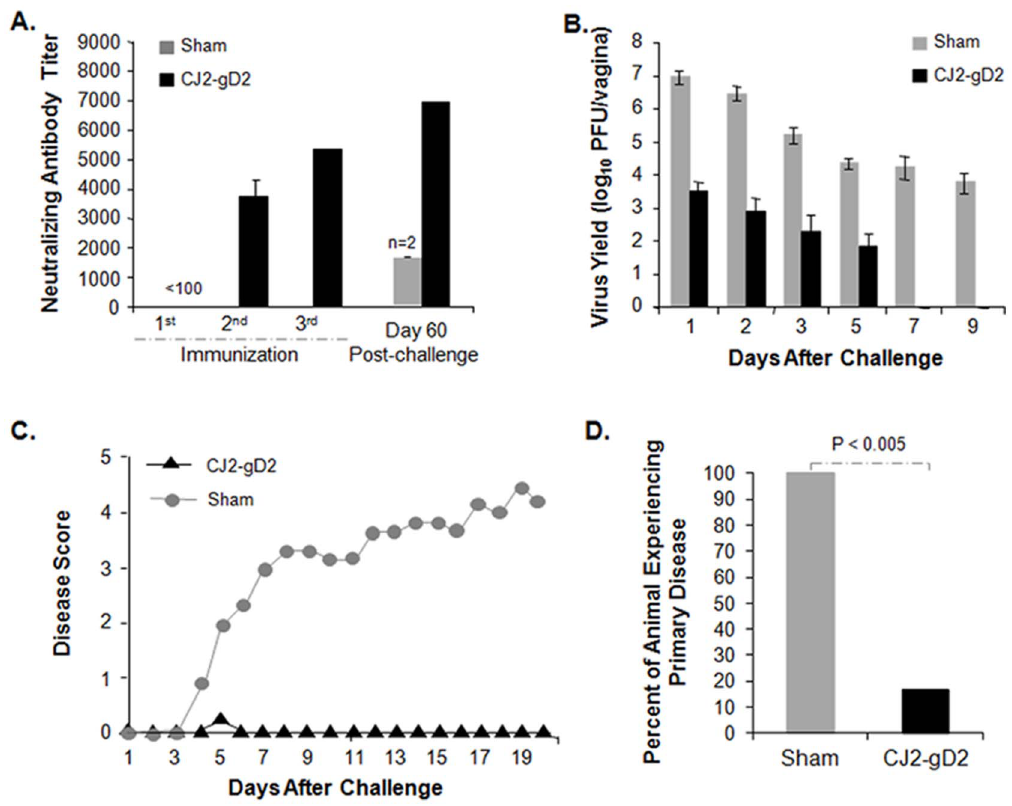
Figure 1. CJ2-gD2 is highly effective in eliciting HSV-2-specific neutralizing antibodies and protective immunity against HSV-2 primary infection and disease in guinea pigs. Female Hartley guinea pigs were randomly assigned to two groups of six animals each and were either sham-immunized with DMEM or immunized with CJ2-gD2 at a dose of 5 6 10 6 PFU by intramuscular injection into the quadriceps of the left and right hind limbs on days 0, 15, and 29. A. Blood was taken on days 14, 28, and 49 after the primary immunization or 60 days after challenge and HSV-2-specific neutralizing antibodies in individual serums were determined. The results represent average titers 6 SEM. B. Three weeks after the third immunization, guinea pigs were preswabbed and infected intravaginally with 5 6 10 5 PFU of wild-type HSV-2 strain MS. Vaginal swabs were taken on days 1, 2, 3, 5, 7, and 9 post-infection. Virus yields in swab materials were determined by standard plaque assay on Vero cell monolayers and expressed as the mean 6 SEM for individual vaginal swabs. C and D. Following infection with wild-type HSV-2, sham-immunized and CJ2-gD2- immunized guinea pigs were monitored daily from days 0 to 60 for the incidence of genital and disseminated HSV-2 disease. Presented is the disease score for the first 20 days after challenge (C) and the percent of animals that experienced primary herpetic disease (D).